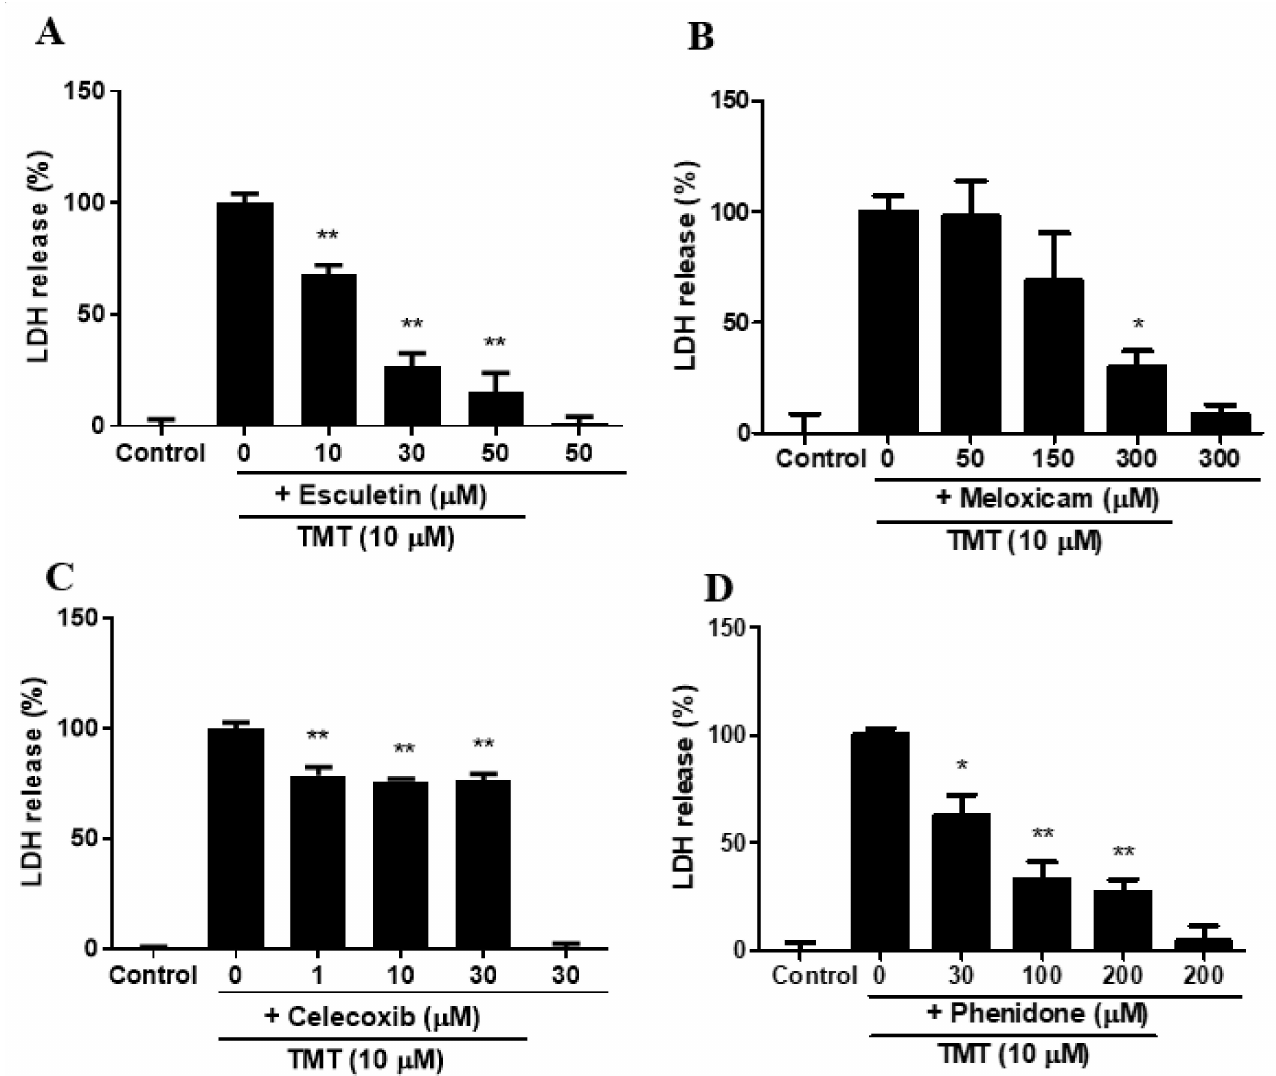
Figure 6. Lipoxygenase (LOX) inhibitor, esculetin ( A ); cyclooxygenase-2 (COX-2) inhibitors, meloxicam ( B ) and celecoxib ( C ); and inhibitor of both LOX and COX-2, phenidone ( D ), significantly attenuated TMT-induced neurotoxicity in SH-SY5Y cells. * p < 0.05 and ** p < 0.01 compared to 10- µ M TMT-treated group ( n = 4). Experiments were performed at least three times, with similar